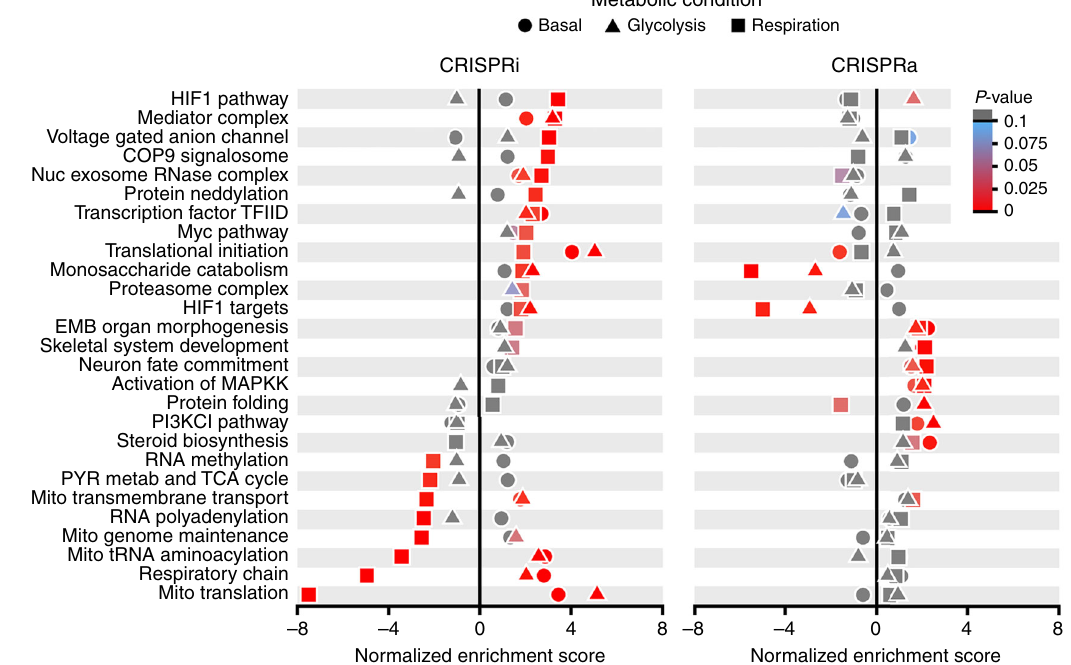
Fig. 2 CRISPR screens identify genetic pathways that regulate ATP level. Gene set enrichment analysis on all screened genes (CRISPRi left and CRISPRa right) listed based on CRISPRi ATP phenotype in respiratory conditions, reveals enrichment of pathways and gene ontologies that regulate ATP levels under basal metabolism (circles), metabolism restricted to respiration only (squares), or glycolysis only (triangles). Signi fi cantly enriched pathways and ontologies are colored red. Pathways enriched with CRISPRa were mostly distinct from those enriched by CRISPRi. Source data are provided as a Source data fi le. P -value is estimated with GSEA software using an empirical phenotype-based permutation test. Multiple testing correction via false discovery rate estimation and exact p -values for each pathway are provided in Supplementary Data